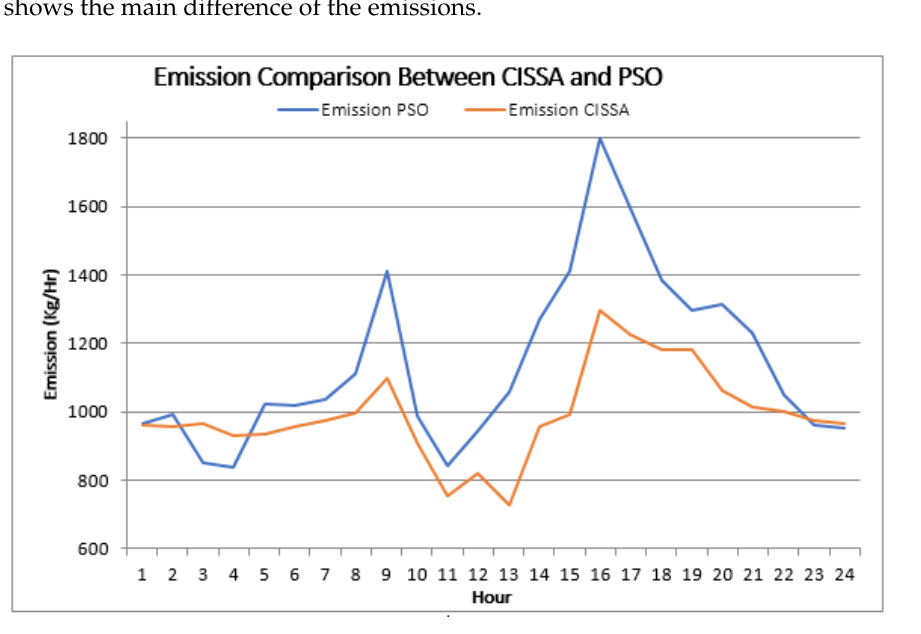
Figure 11. Emissions comparison between CISSA and PSO. Table 20. Reduction in daily emissions—case study 2.